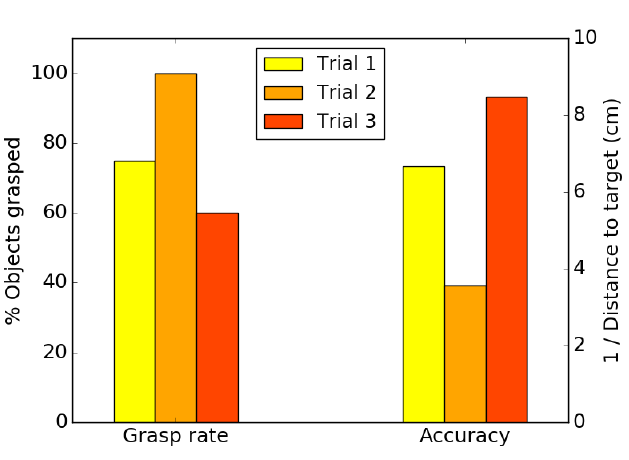
Figure 19. Pick and Placing FBM results per